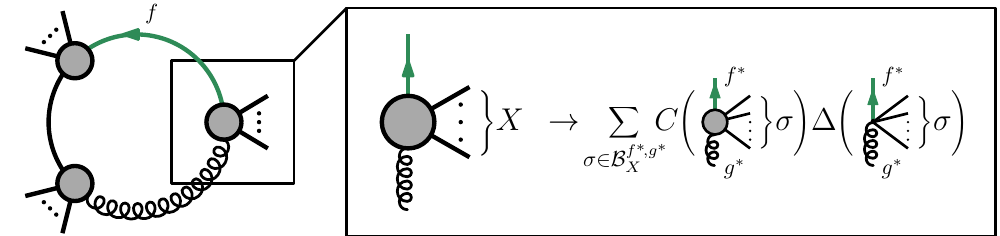
Figure 5 . Inserting a quark-gluon stretch tree basis into coloured cuts of a one-loop amplitude. the colour factor through the colour factorisation relation (2.2). Therefore, all colour- ordered numerators related by factorisation come with the same colour